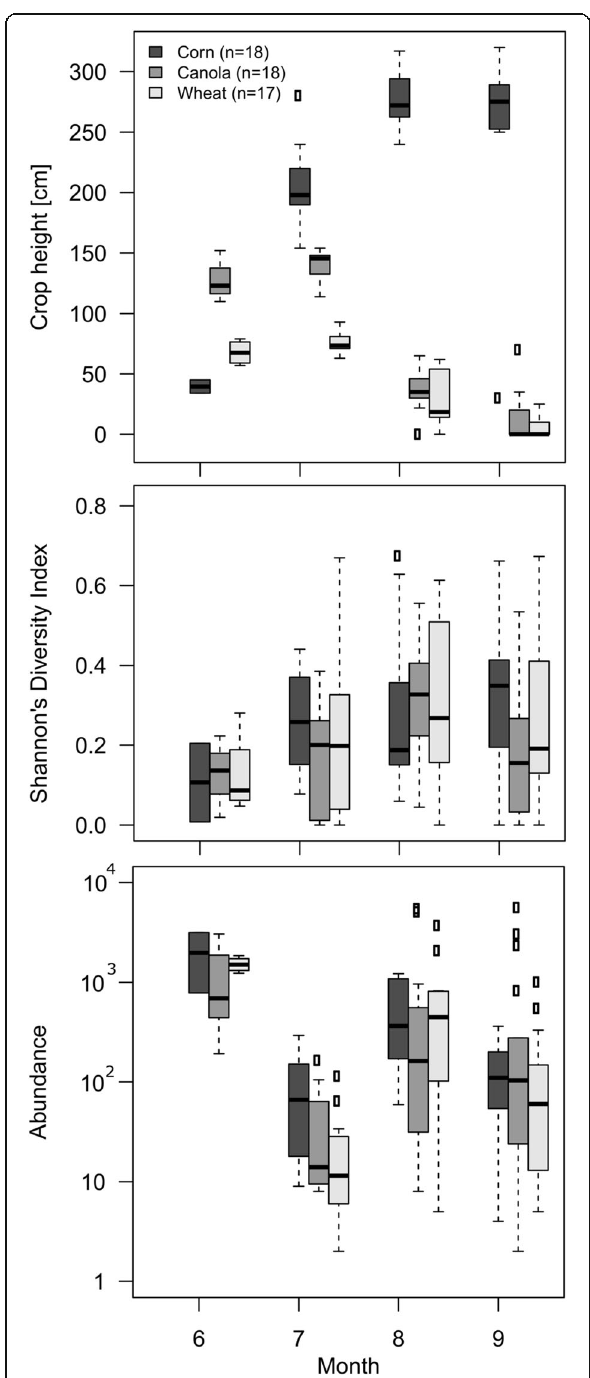
Fig. 5 Variation of crop height, insect diversity (on order level), and insect abundance from June to September 2012 on 53 arable fields where the insect and bat monitoring was